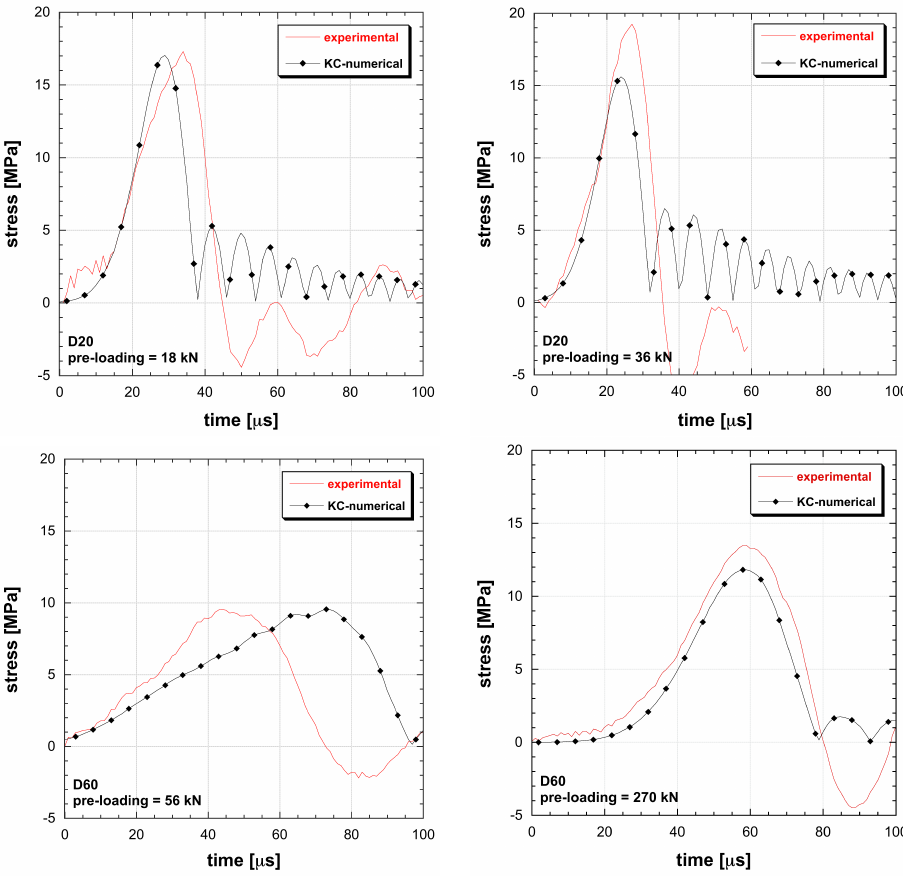
Figure 5. Comparison between experimental and simulated behaviour of UHPC in tension at different loading rate and size (M72R3 (K&C) material